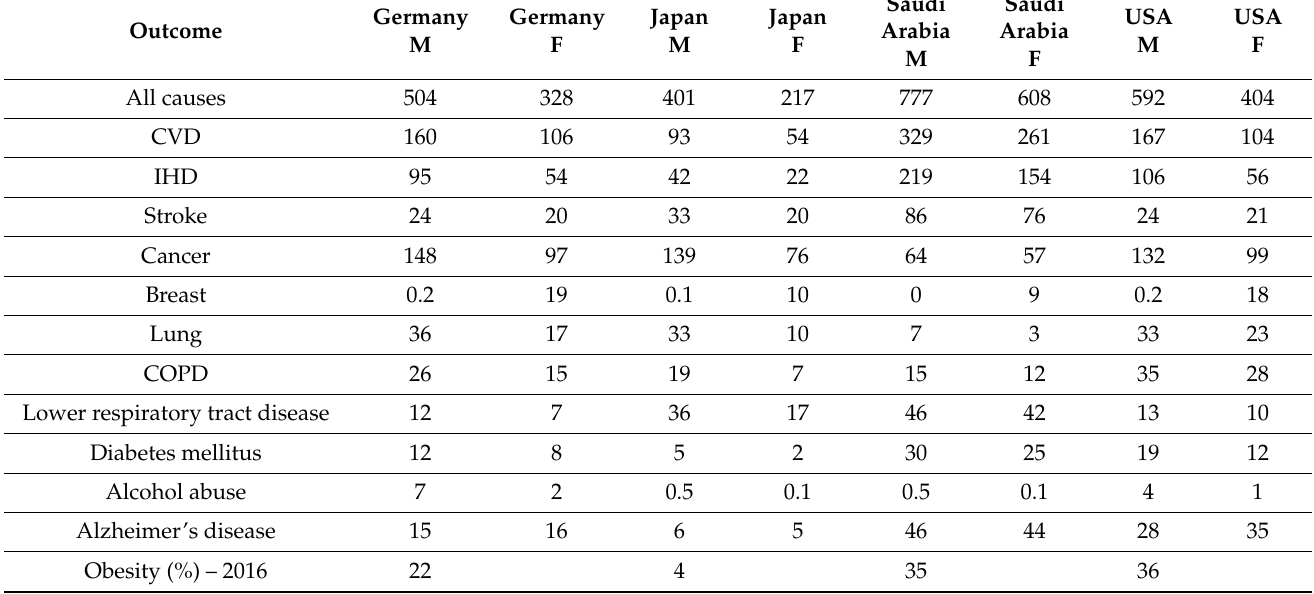
Table 1. Global Health Estimates 2016: Deaths by Cause, Age, Sex, by Country and by Region, 2000–2016. Geneva, World Health Organization; 2018. Obesity data from https://obesity.procon.org/global-obesity-levels/